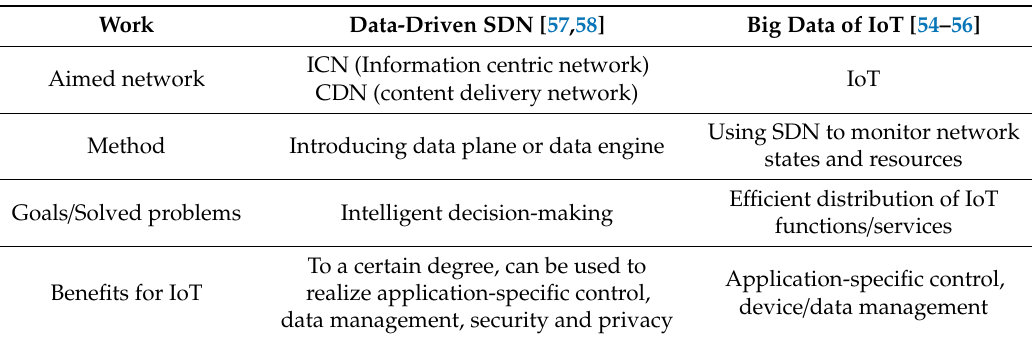
Table 4. Current work about data for SDN and